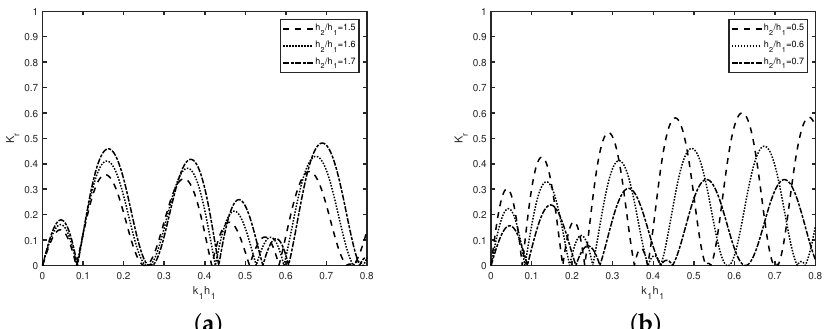
Figure 9. K r versus k 1 h 1 in case of different depth h 2 / h 1 of double rectangular ( a ) trenches with w / L 1 = 0.6, d / L 1 = 0.86; ( b ) breakwaters with w / L 1 = 0.35, d / L 1 = 0.6 in the absence of a semi-infinite